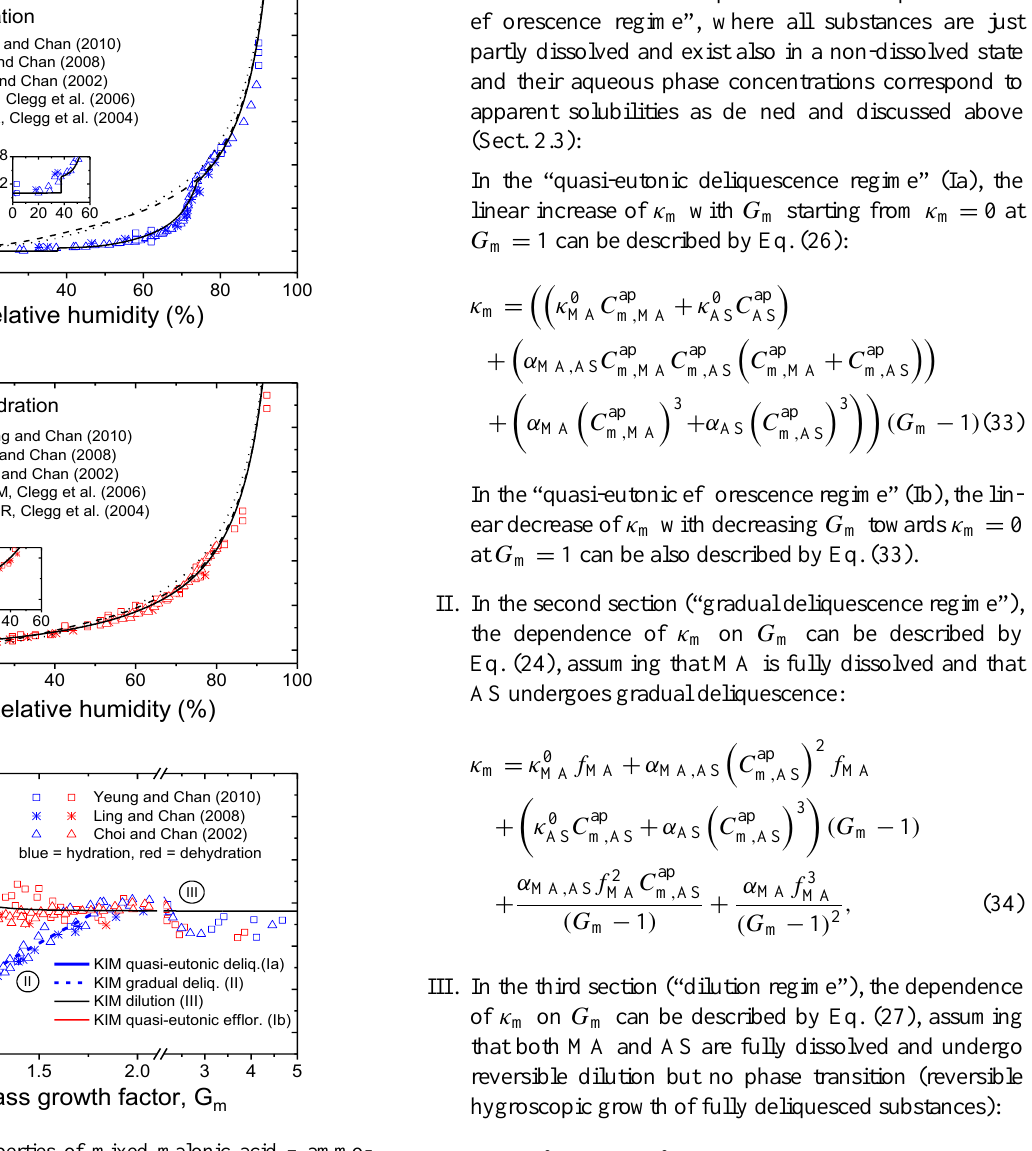
Fig. 5. Hygroscopic properties of mixed malonic acid – ammonium sulfate particles (MA-AS, mole ratio 1 : 1): (a, b) mass growth factors ( G m ) observed as a function of relative humidity upon hydration (blue) and dehydration (red). ( c ) Mass-based hygroscopicity parameters ( κ m ) calculated as a function of mass growth factor (Eq. 10). Labels Ia, Ib, II, and III indicate different regimes of hygroscopicity. Data points: EDB experiments (stars) from Ling and Chan (2008), SEDB experiments (triangles) from Choi and Chan (2002), and micro-Raman experiments (squares) from Yeung and Chan (2010). Model lines: (a, b) KIM – black solid; E-AIM, Clegg et al. (2006) – black dashed; E-ZSR, Clegg et al. (2004) – black dotted; (c) KIM: quasi-eutonic deliquescence regime – blue solid; gradual deliquescence regime – blue dashed; dilution regime – black solid; quasi-eutonic efflorescence regime – red solid.